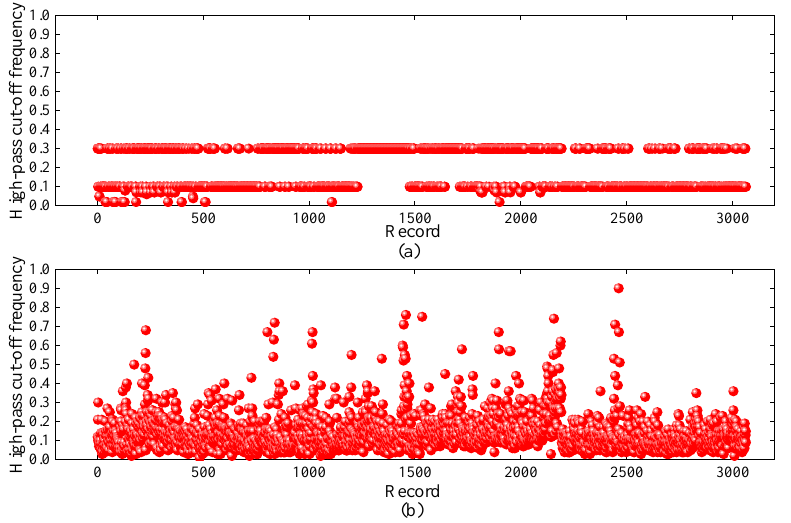
Figure 2. The high-pass cut-off frequency for each record. ( a ) CESMD; ( b ) traditional method. The partial acceleration, velocity, and displacement time series curves of record AK- BAW--n.0212o88mof.BNE after filtering with different high-pass cut-off frequencies are shown in Figure 3. It was observed that the displacement time series curves obtained via filtering with the value before the accurate value as the cut-off frequency were all unqual- ified, and the ones after that were all qualified.